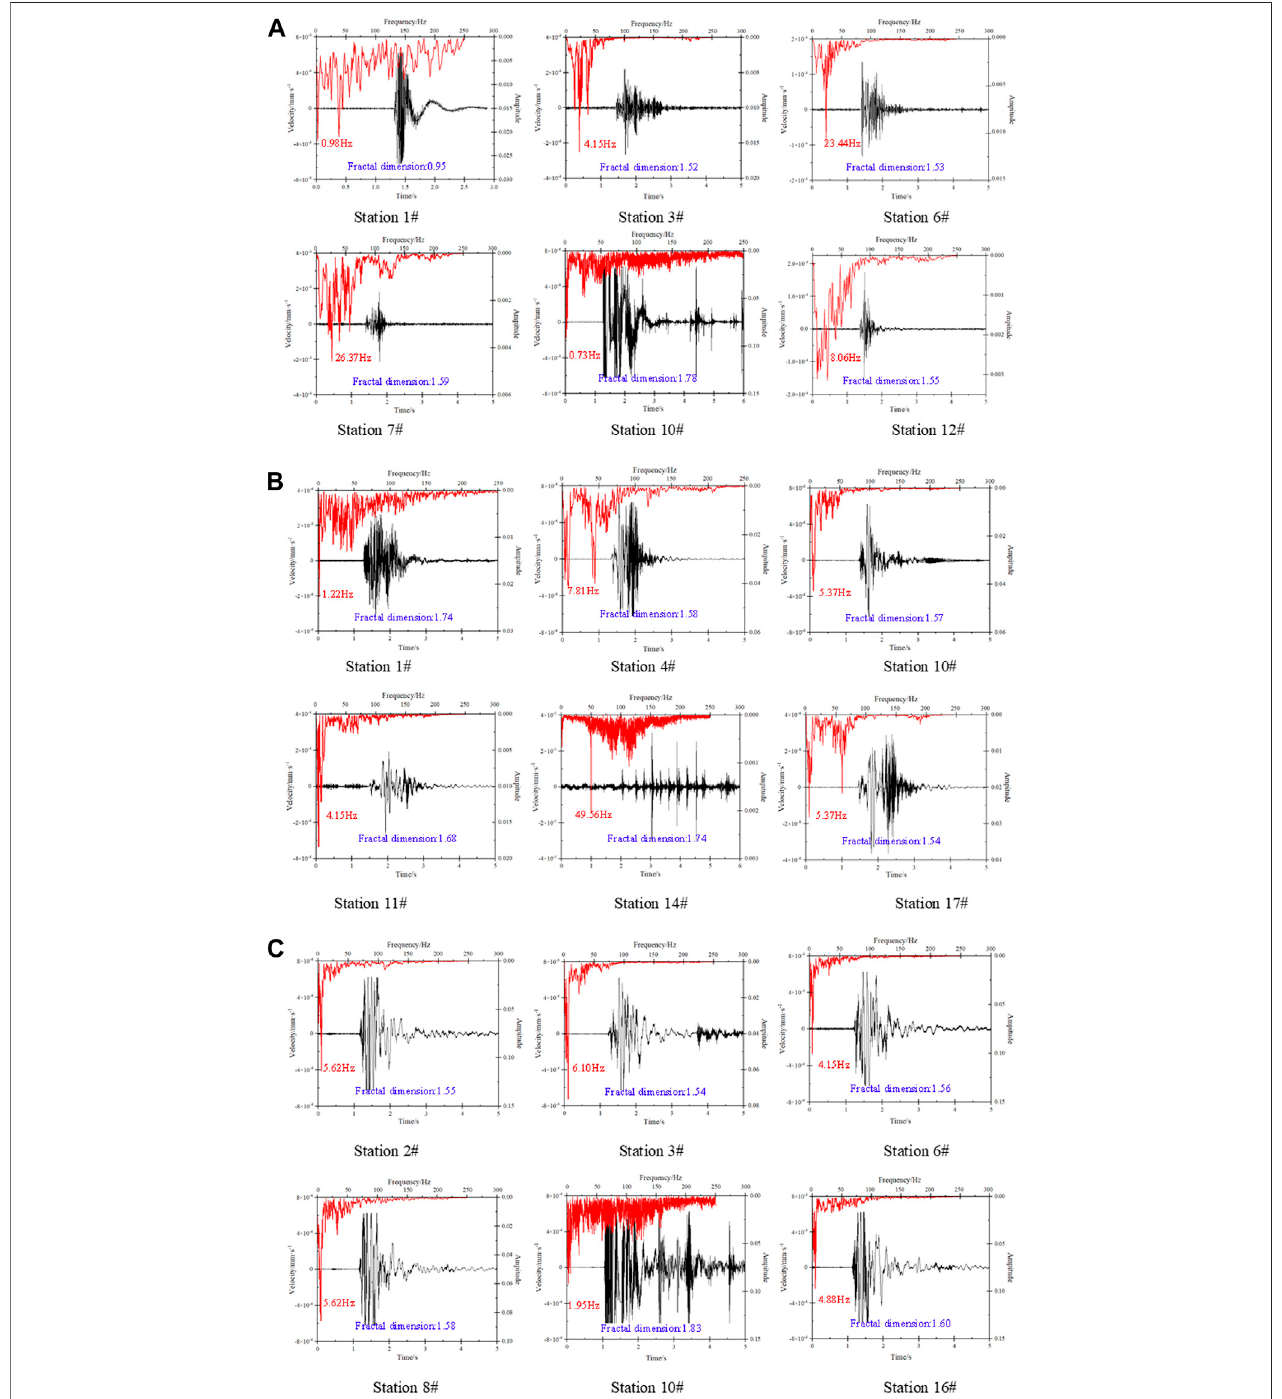
FIGURE 10 | Typical burst waveform, frequency spectrum characteristics and fractal dimension. (A) The “ 2019.09.12 ” burst event; (B) The “ 2020.01.08 ” burst event; (C) The “ 2020.05.24 ” burst event.